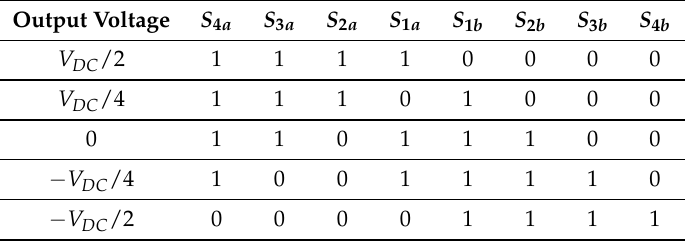
Figure 9. Basic configuration of 5-level inverter based on FC. Table 8. 5L-FC operation modes.